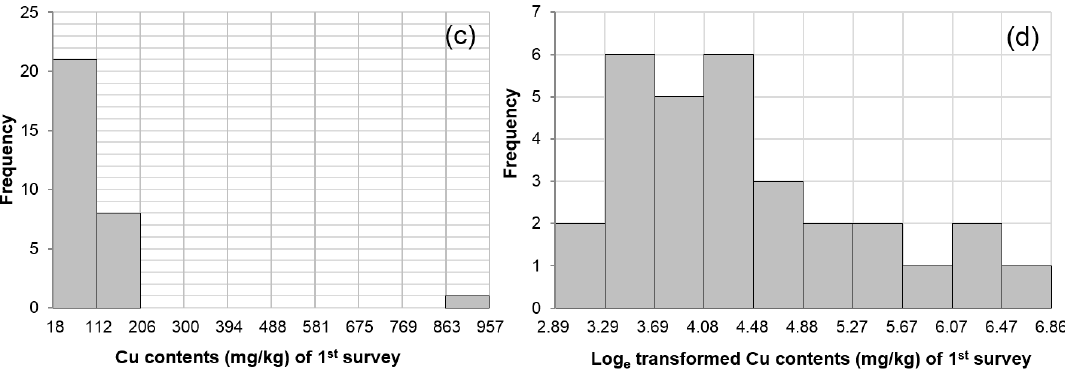
Figure 7. Histograms of copper content analyzed with the PXRF instrument. ( a ) All raw data of copper by PXRF; ( b ) Natural logarithms of the all raw data; ( c ) 30 raw data samples of copper by PXRF without second survey; ( d ) Natural logarithms of the 30 raw data samples without second survey.